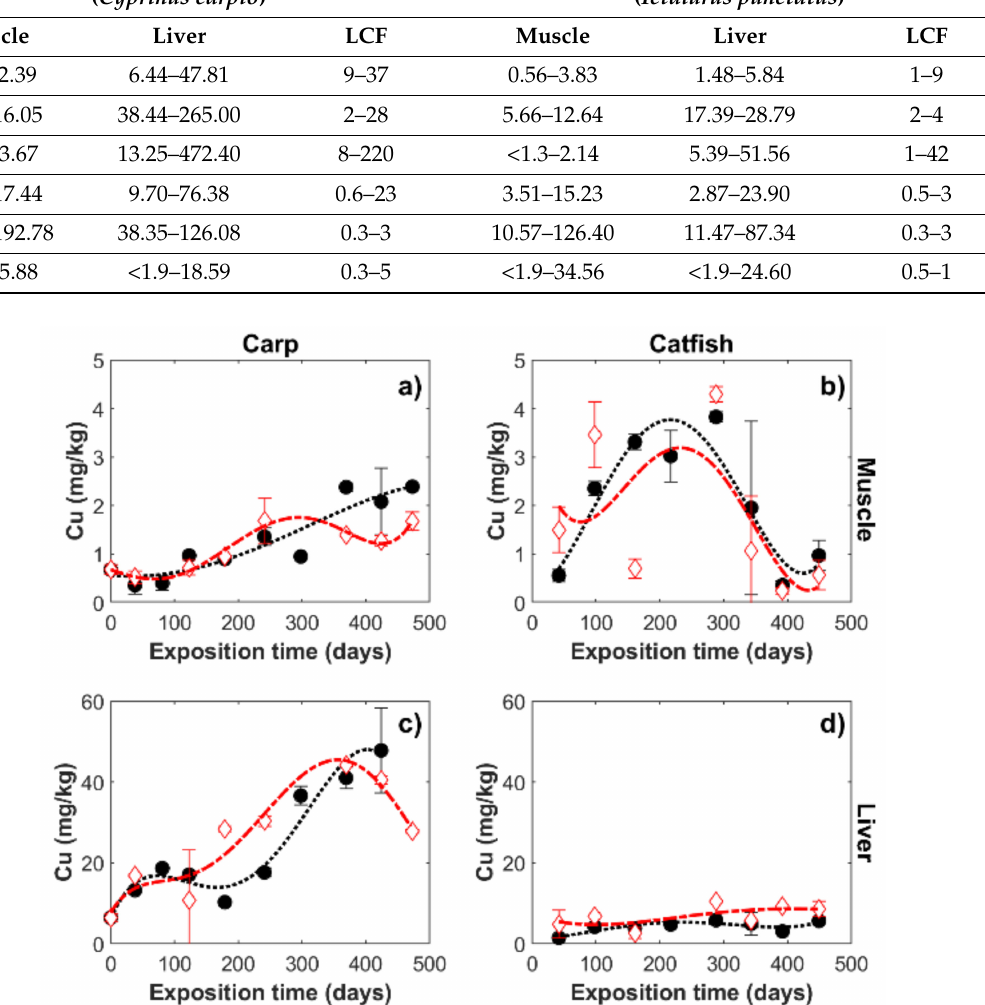
Figure 2. Cu accumulation in the experimental ( • ) and control groups ( carp, ( b ) muscle in catfish, ( c ) liver in carp, and ( d ) liver in